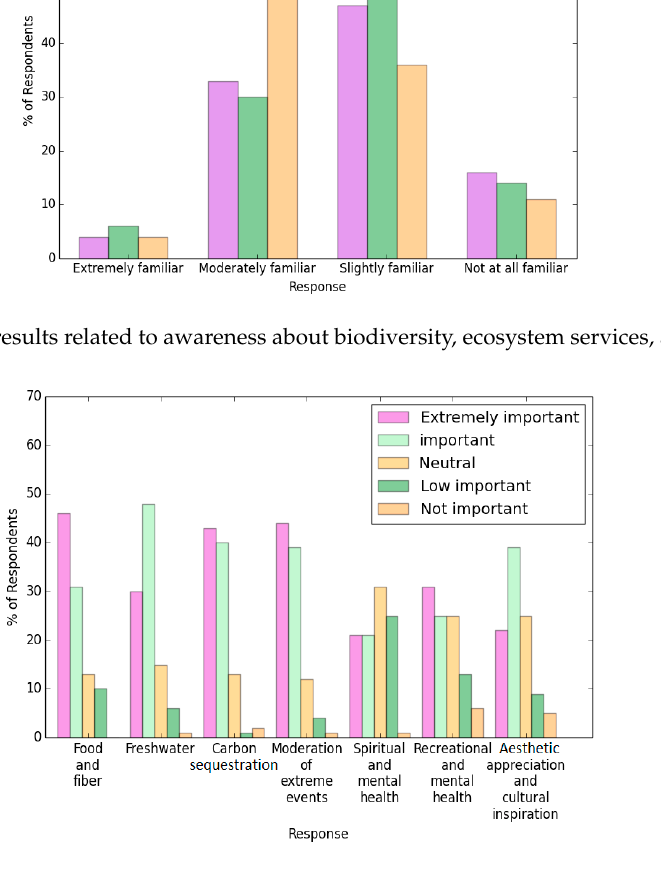
Figure 5. Survey results for the question: “The following are various services provided by nature in Xi’an. How important are they to YOU?”.